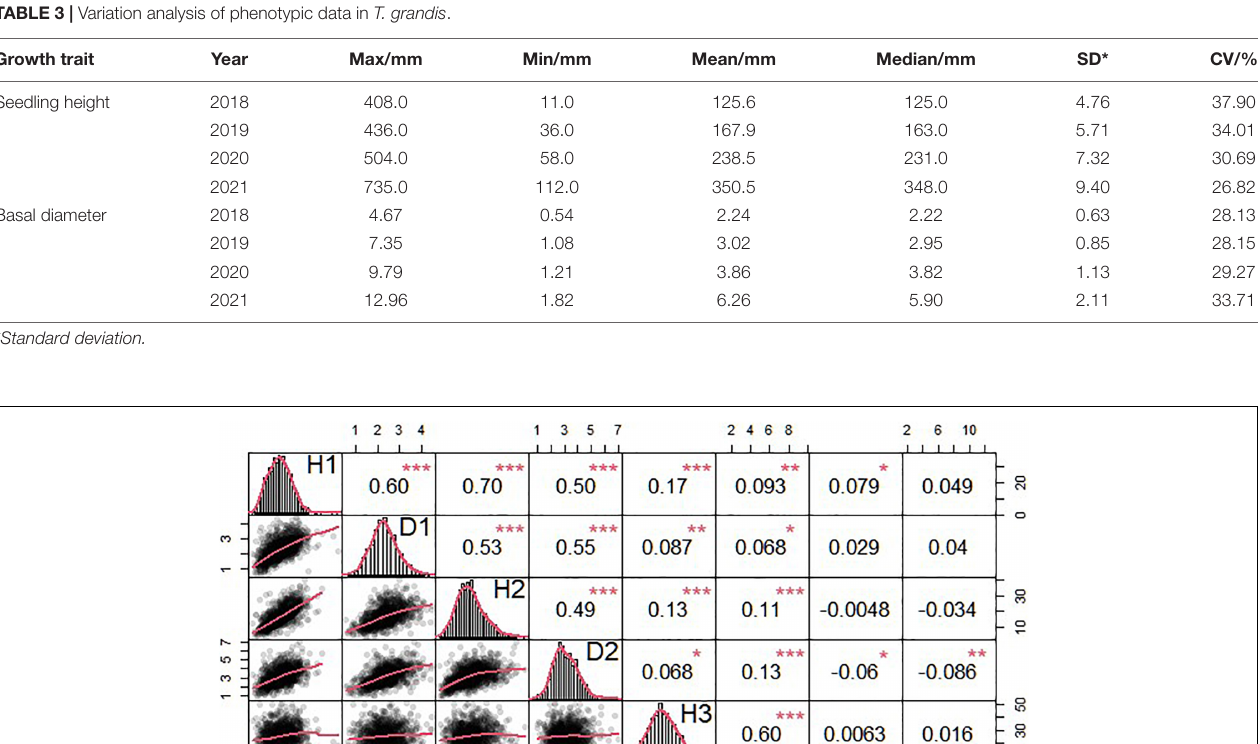
On diagonal are the number and proportion (in parentheses) of significant marker pairs on individual linkage groups.